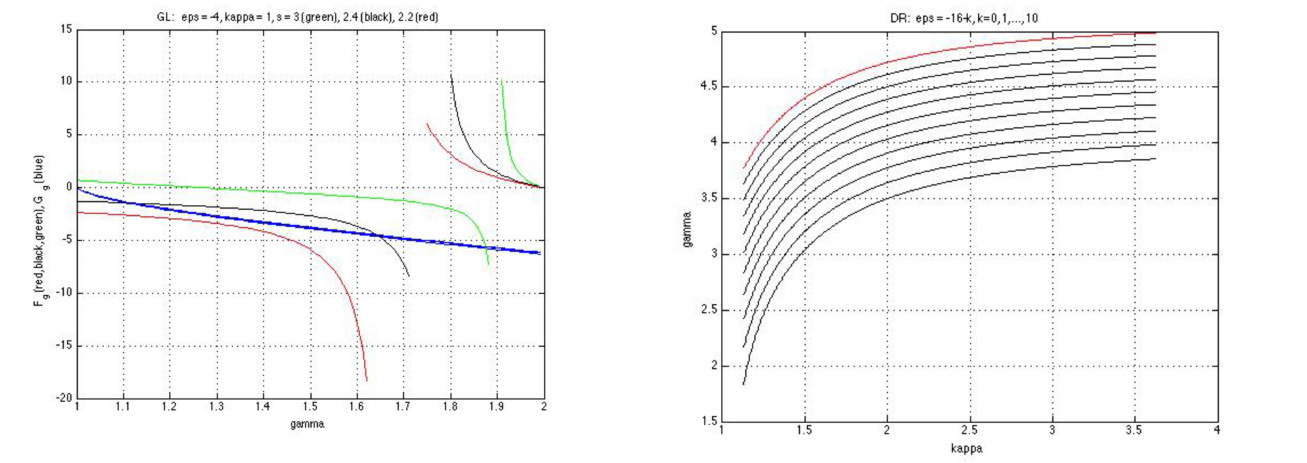
Figure 8: Plots of γ 1 = γ 1 ( κ ) solving DE (9) for the funda- mental DR surface modes vs κ for (cid:15) = − 15 − k from k = 0 (upper black curve) to k = 10 (lower red curve).